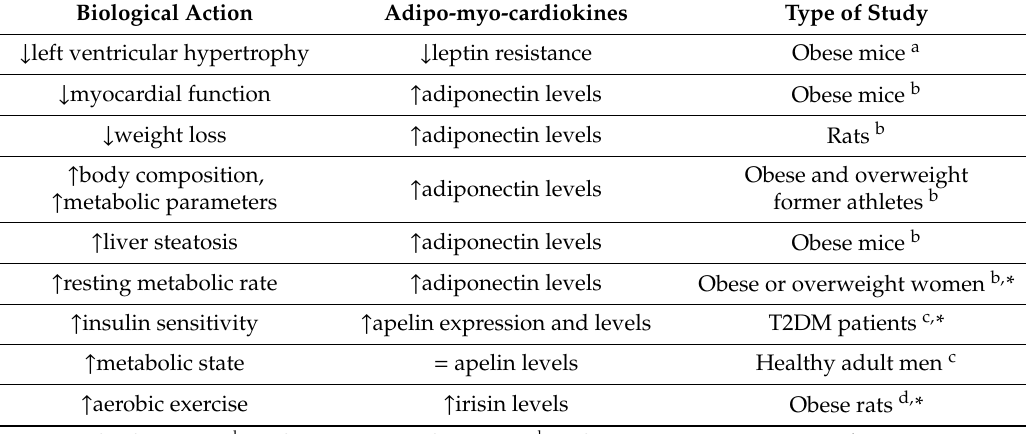
Table 1. E ff ects of caloric restriction on adipokines, myokines, and cardiokines.